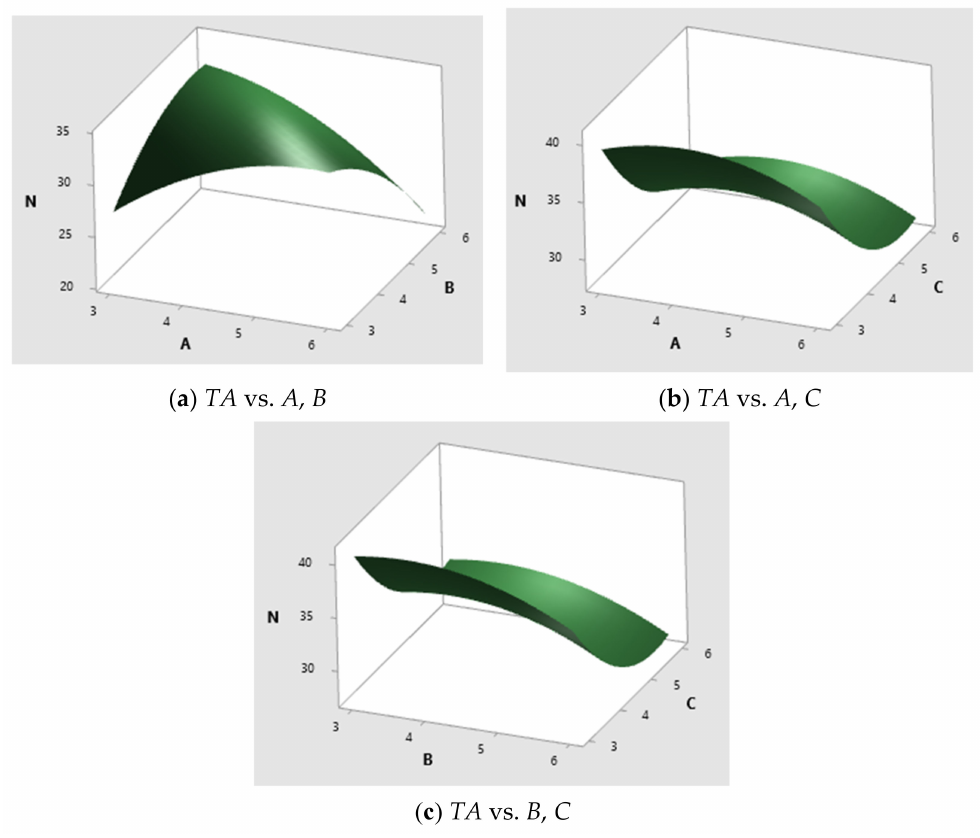
Figure 5. Surface